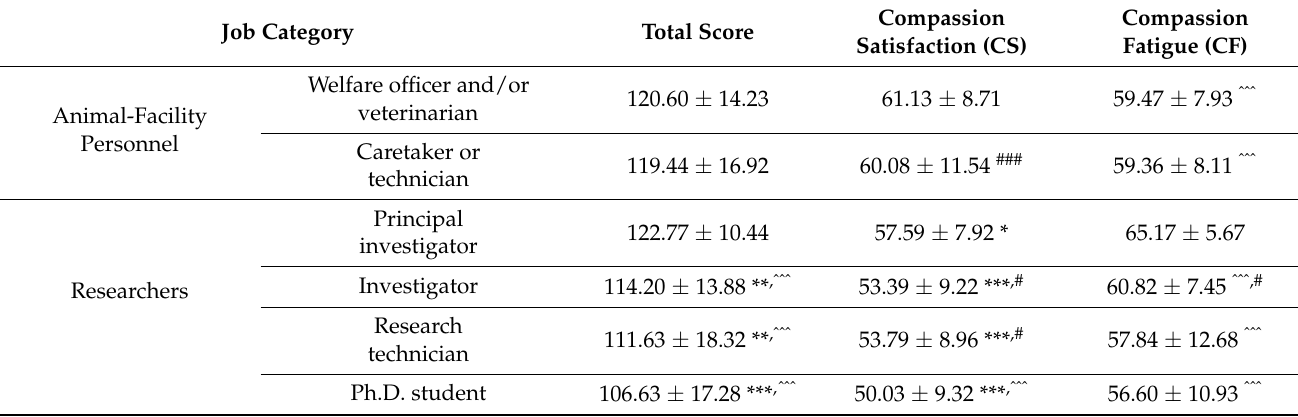
Table 2. Professional quality of life scale and subscales scores by job category. Data are presented as group mean ± SD. ˆˆˆ p < 0.001 versus principal investigator; * p < 0.05, ** p < 0.01, *** p < 0.001 versus welfare officer and/or veterinarian; # p < 0.05, ### p < 0.001 versus PhD